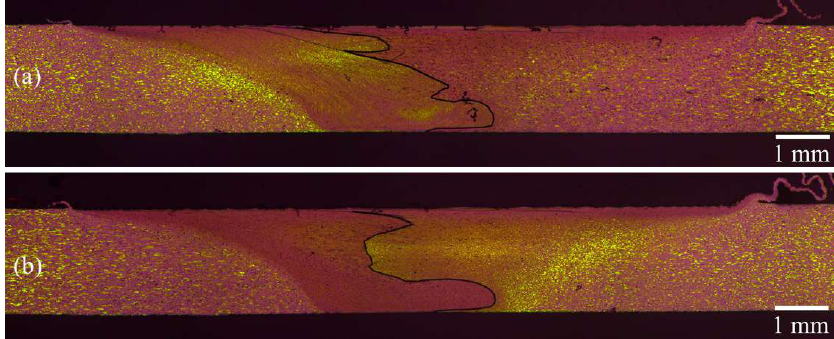
Figure 5. Cross sections of ( a ) FSW-WS = 3-AA7050-R and ( b ) FSW-WS = 3-AA2024-R.